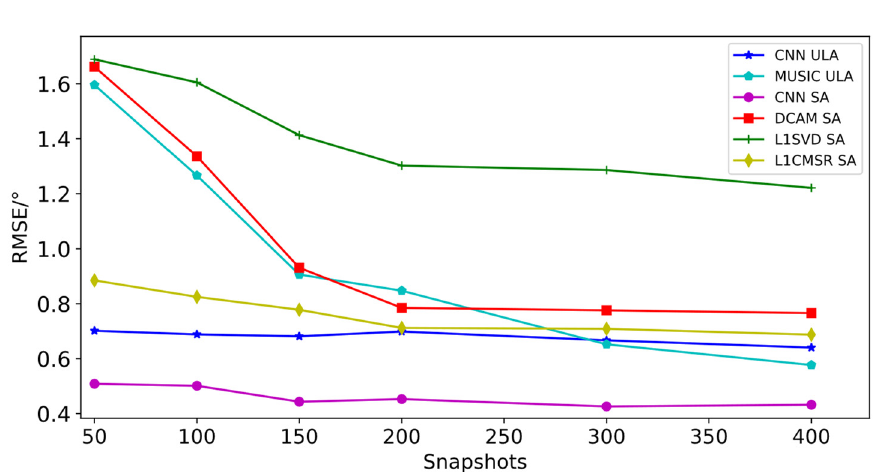
Figure 5. Comparison of RMSE of various algorithms with different snapshots.